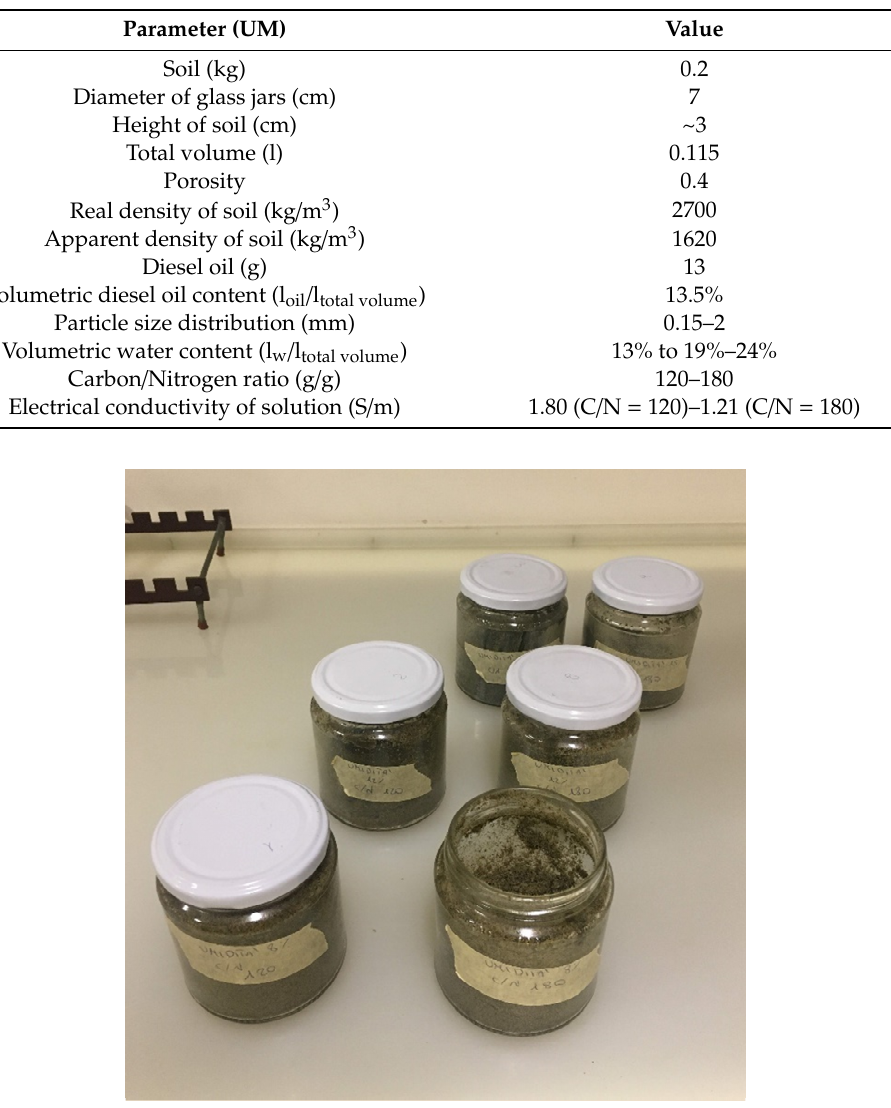
Table 1. Main properties of microcosms.